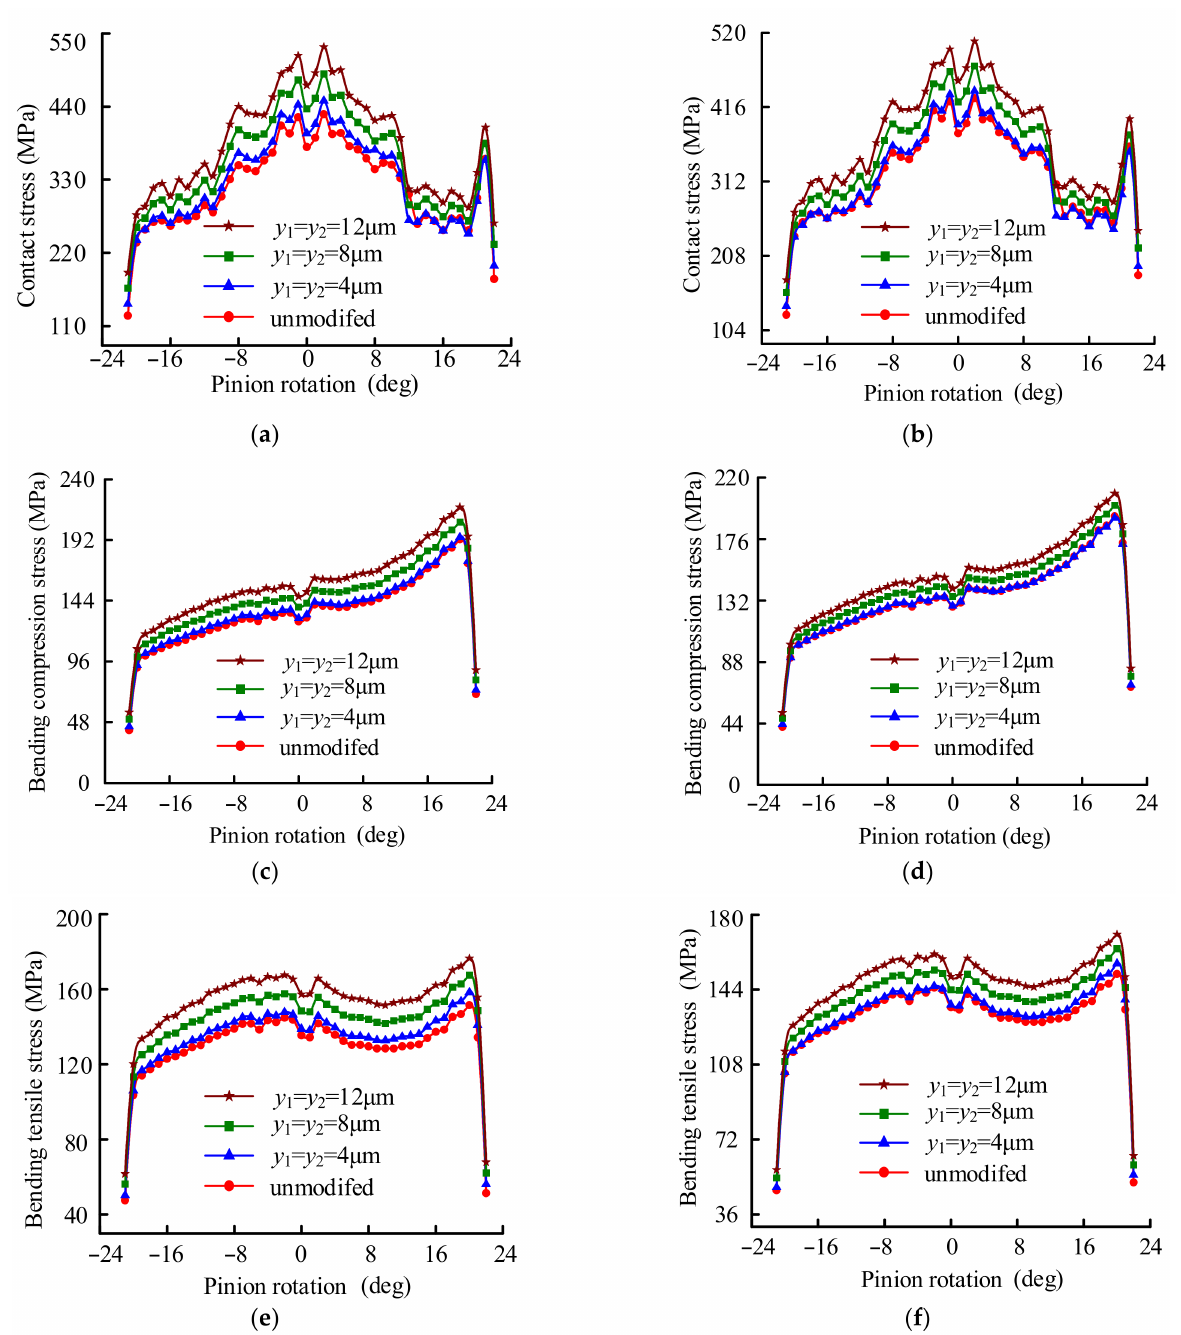
Figure 16. Comparison of stress of novel gears with different values of tooth modification. ( a ) Contact stress, y 3 = 0; ( b ) Contact stress, y 3 = 8 mm; ( c ) Bending compressive stress, y 3 = 0; ( d ) Bending compressive stress, y 3 = 8 mm; ( e ) Bending tensile stress, y 3 = 0; ( f ) Bending tensile stress, y 3 = 8